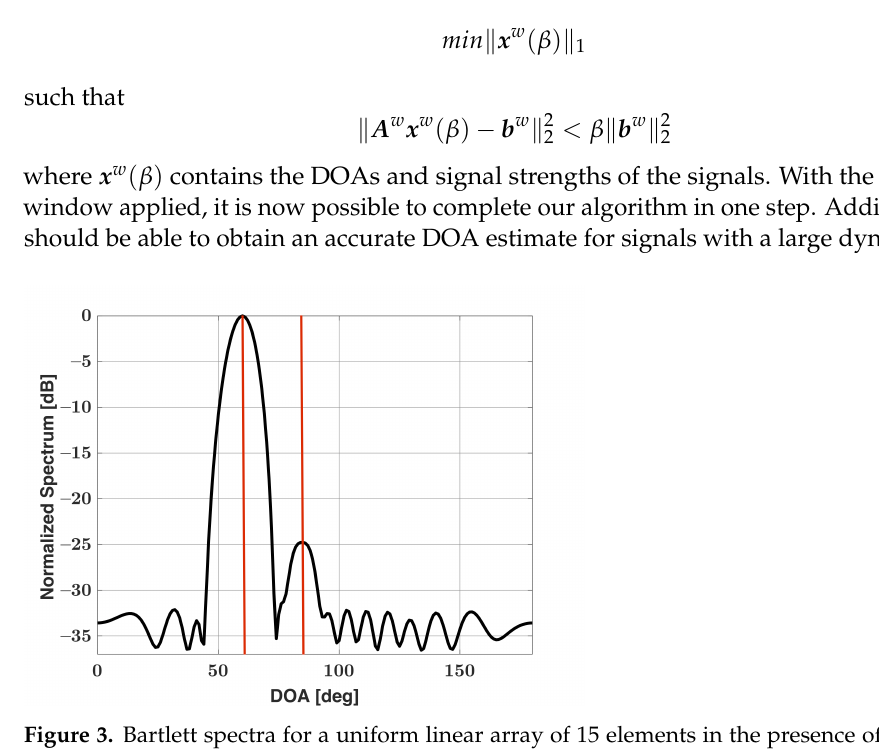
Figure 3. Bartlett spectra for a uniform linear array of 15 elements in the presence of two signals incident at 60 ◦ (25 dB SNR) and 85 ◦ (0 dB SNR), Chebyshev window